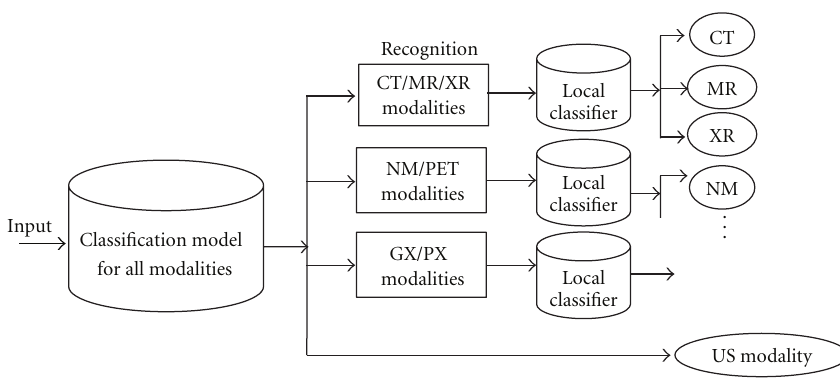
Figure 4: The refinement procedure with the local